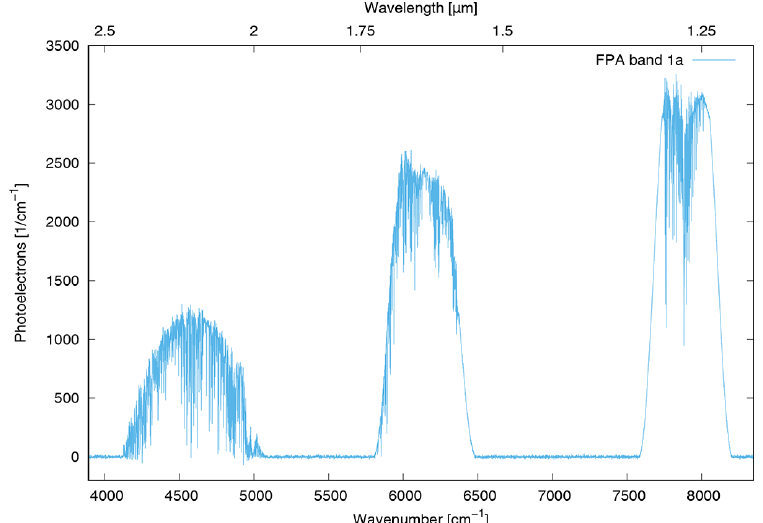
Figure 3. Simulated JPL GEO-IR Sounder spectrum in the SWIR domain. The SWIR domain is subdivided into discrete bands using a triple-band interference filter to maximize the SNR in spectral regions of interest (CO 2 , CH 4 , CO, H 2 O, and O 2 ) .